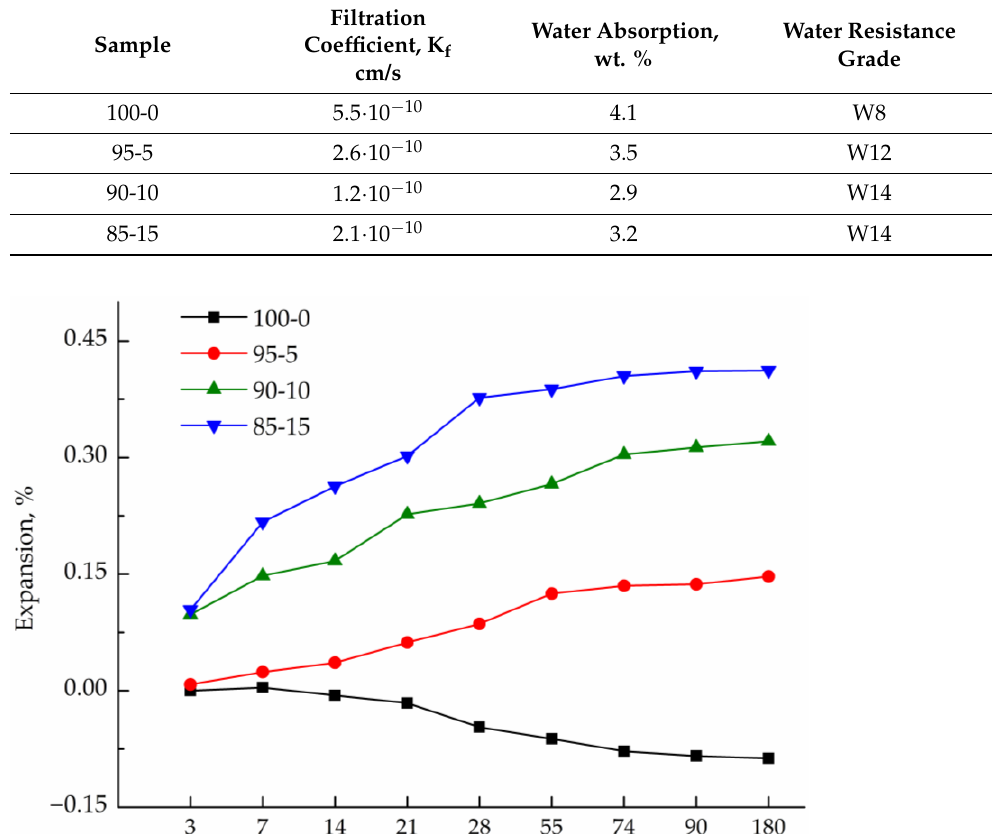
Table 6. Permeability of the mixed cement samples.